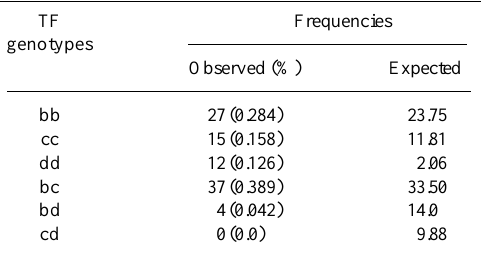
Table II - Observed and expected frequencies of transferrin genotypes in the tambaqui stock of Pentecoste (PE).